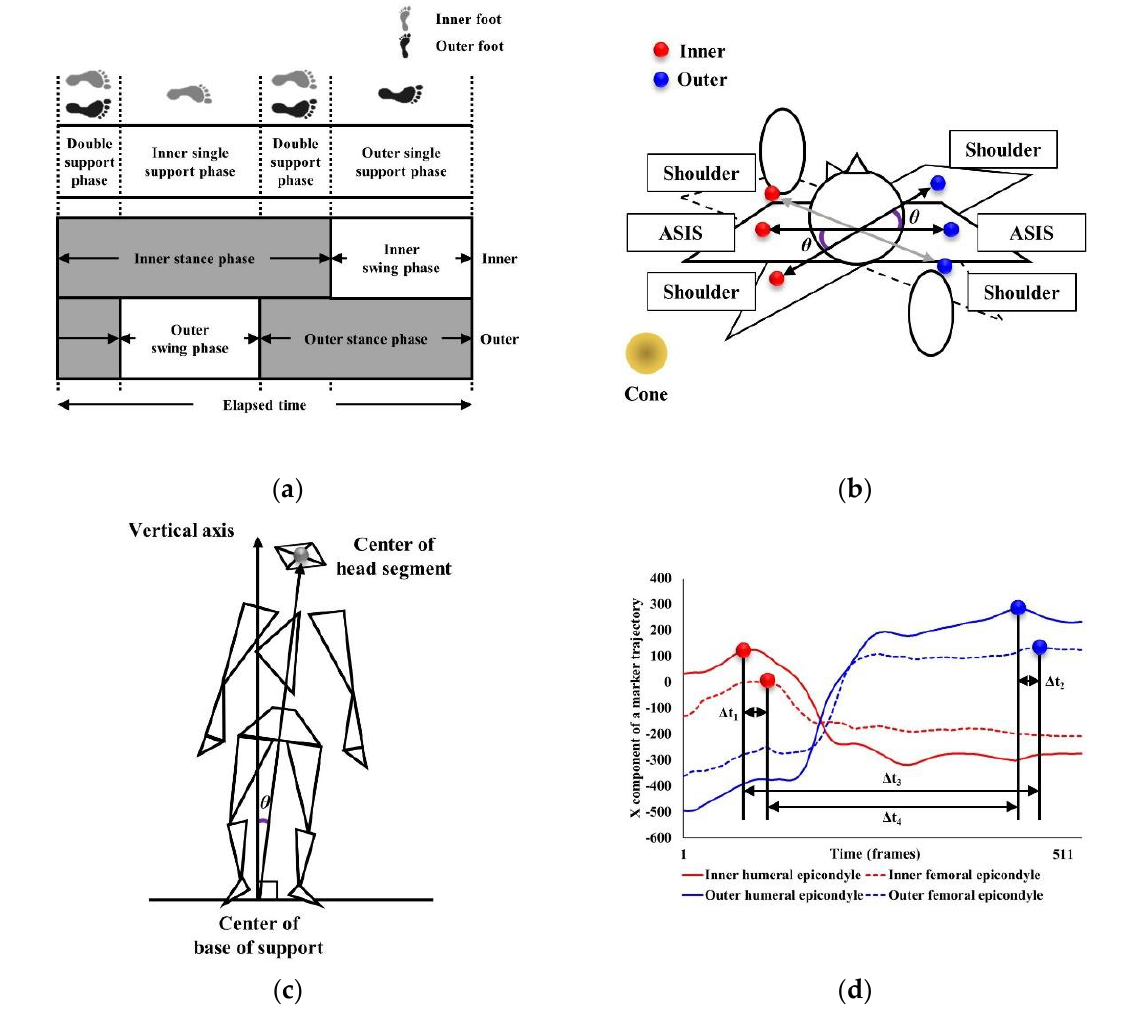
Figure 3. Analysis variables. ( a ) The definition of inner and outer double and single support and stance phases; ( b ) The definition of the maximum anti-phase; ( c ) The definition of the incline angle; and ( d ) The definition of the inner and outer ipsilateral and contralateral temporal coordination parameters of the upper and lower limbs; ASIS, anterior superior iliac spine.